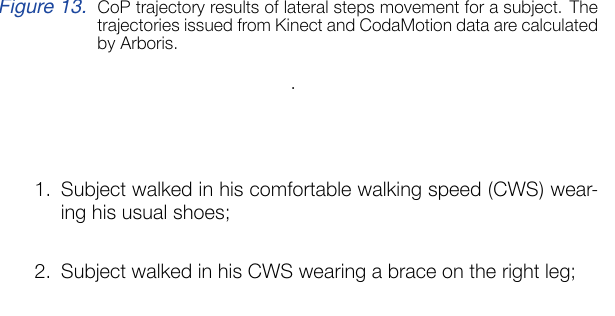
Figure 13. CoP trajectory results of lateral steps movement for a subject. The trajectories issued from Kinect and CodaMotion data are calculated by Arboris.